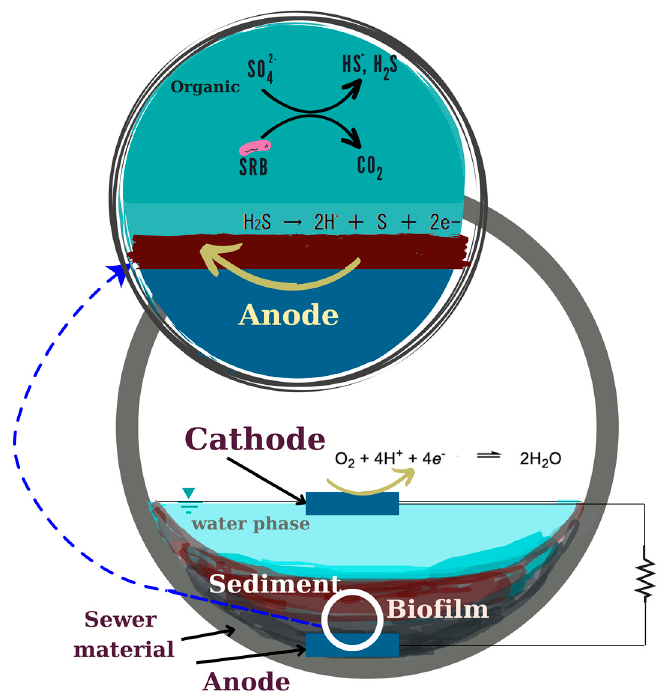
Figure 3. Inhibition mechanism of sulfide by MFC strain .